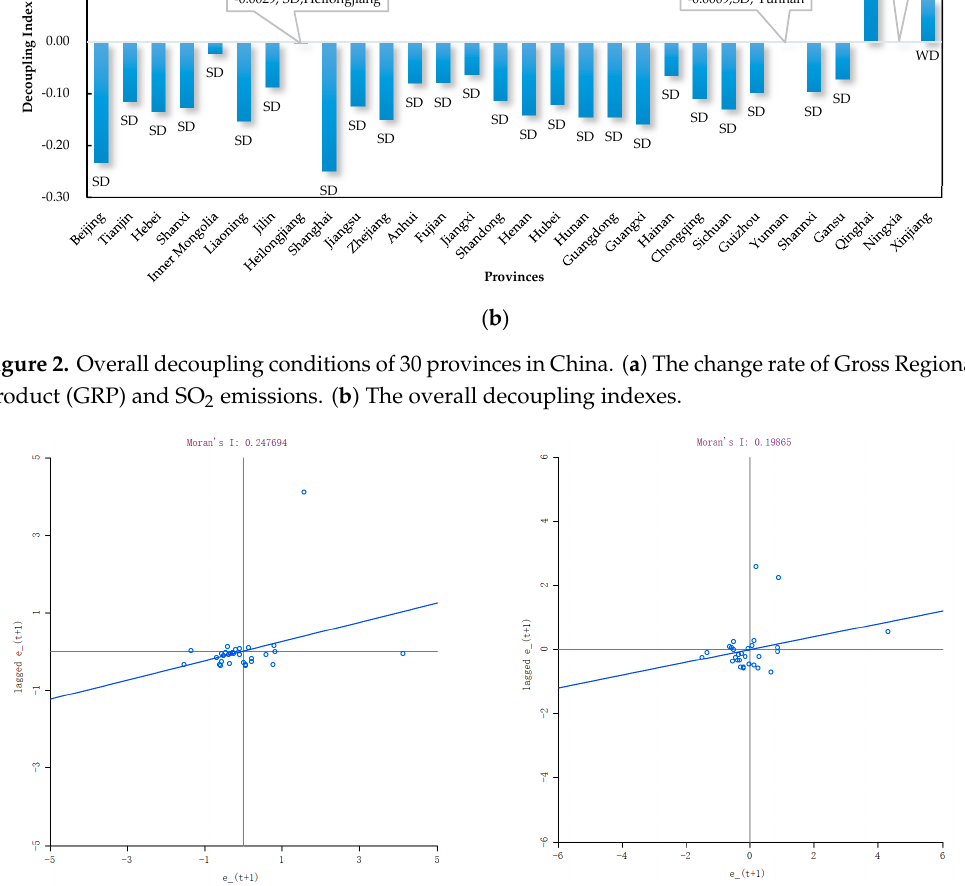
Figure 3. Moran’s Index scatter plot of decoupling index and its significance test. ( a ) Moran’s I scatter plot of 30 provinces. ( b ) Moran’s I scatter plot for robust check.